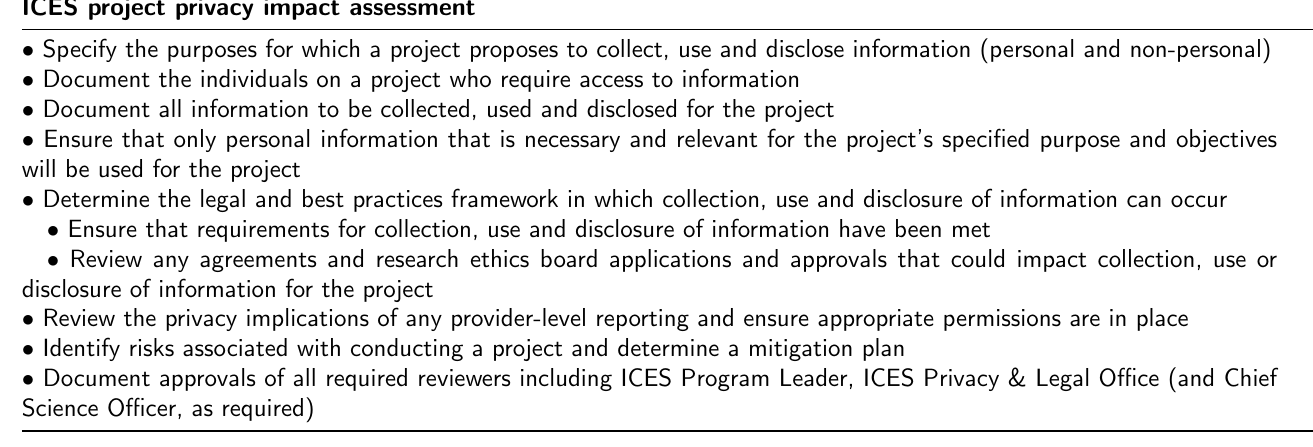
Table 1: The ICES project privacy impact assessment